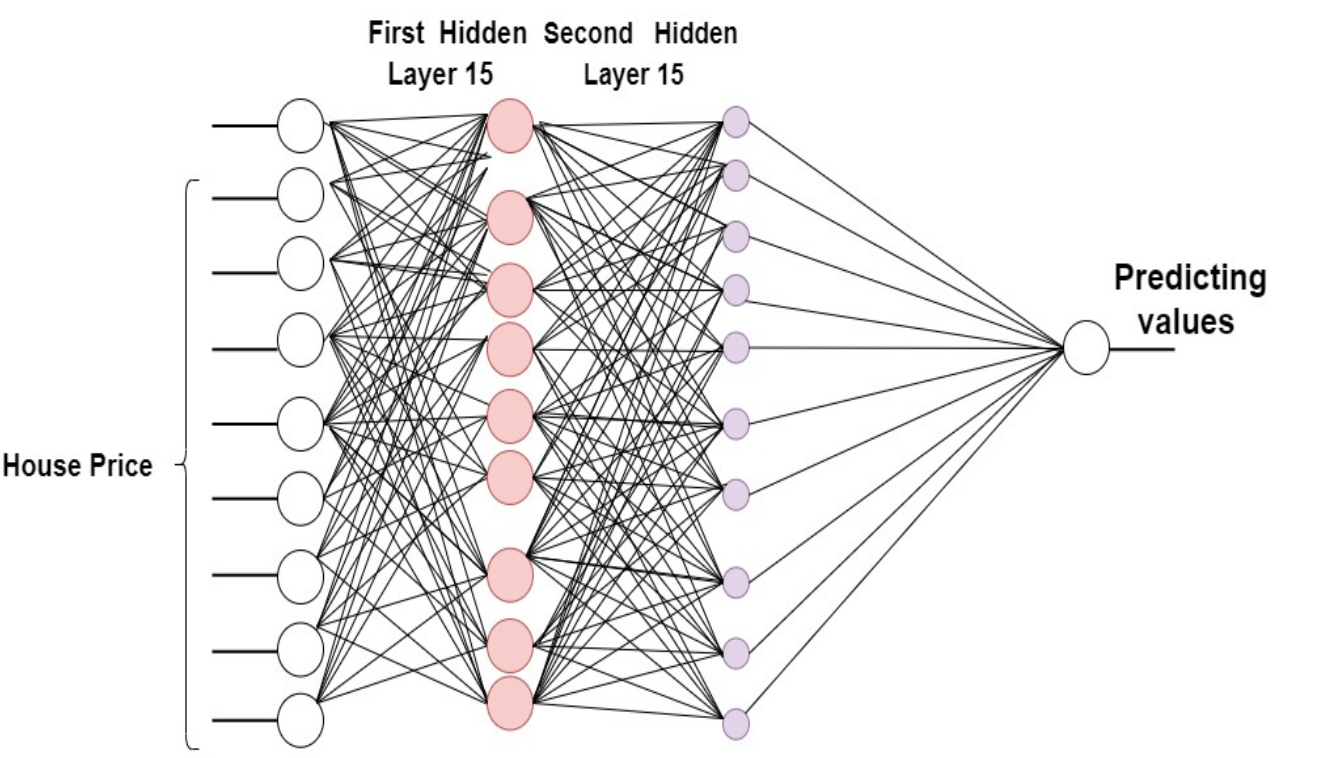
Figure 3. Structure of the ANN model.